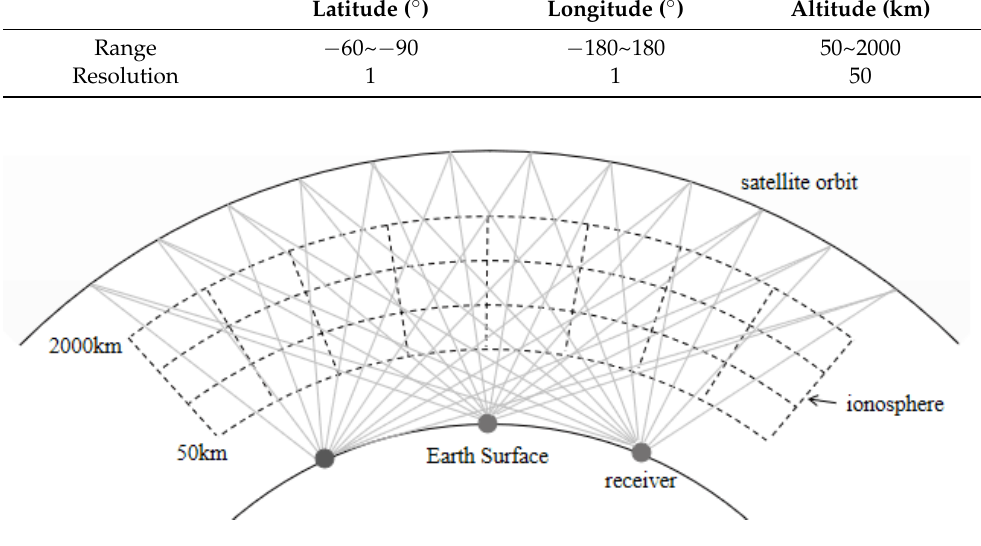
Figure 2. Schematic diagram of the spatial grid model